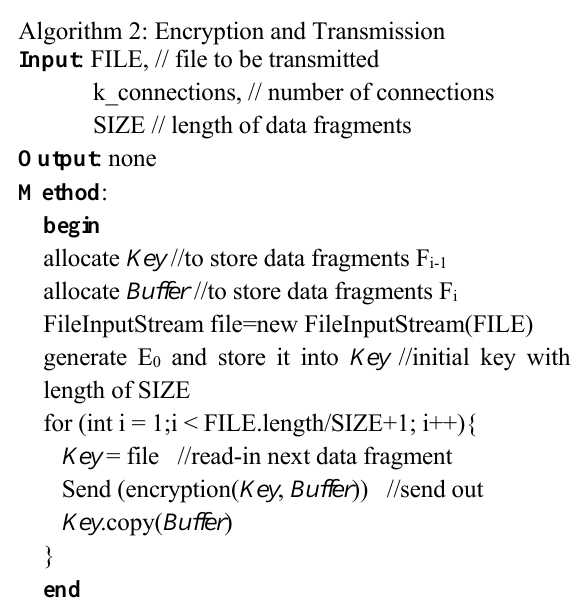
Algorithm 2: Encryption and